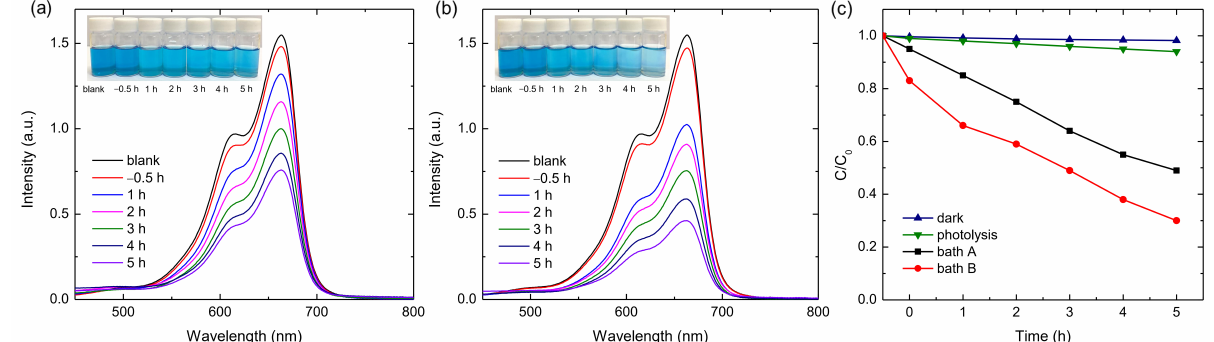
Figure 7. Curves showing photocatalytic properties (PA) of ( a ) bath A and ( b ) bath B samples for degradation of methylene blue (MB) under UV light irradiation for − 0.5 to 5 h. Inset represents photographic observation of MB solution after catalysis. ( c ) Degradation kinetic curve of the oxide layer developed by PEO in bath A and bath B under UV light irradiation for − 0.5 to 5 h. The catalytic degradation of MB under a dark environment without UV irradiation (dark) and under UV irradiation with the absence of samples (photolysis) were added as a